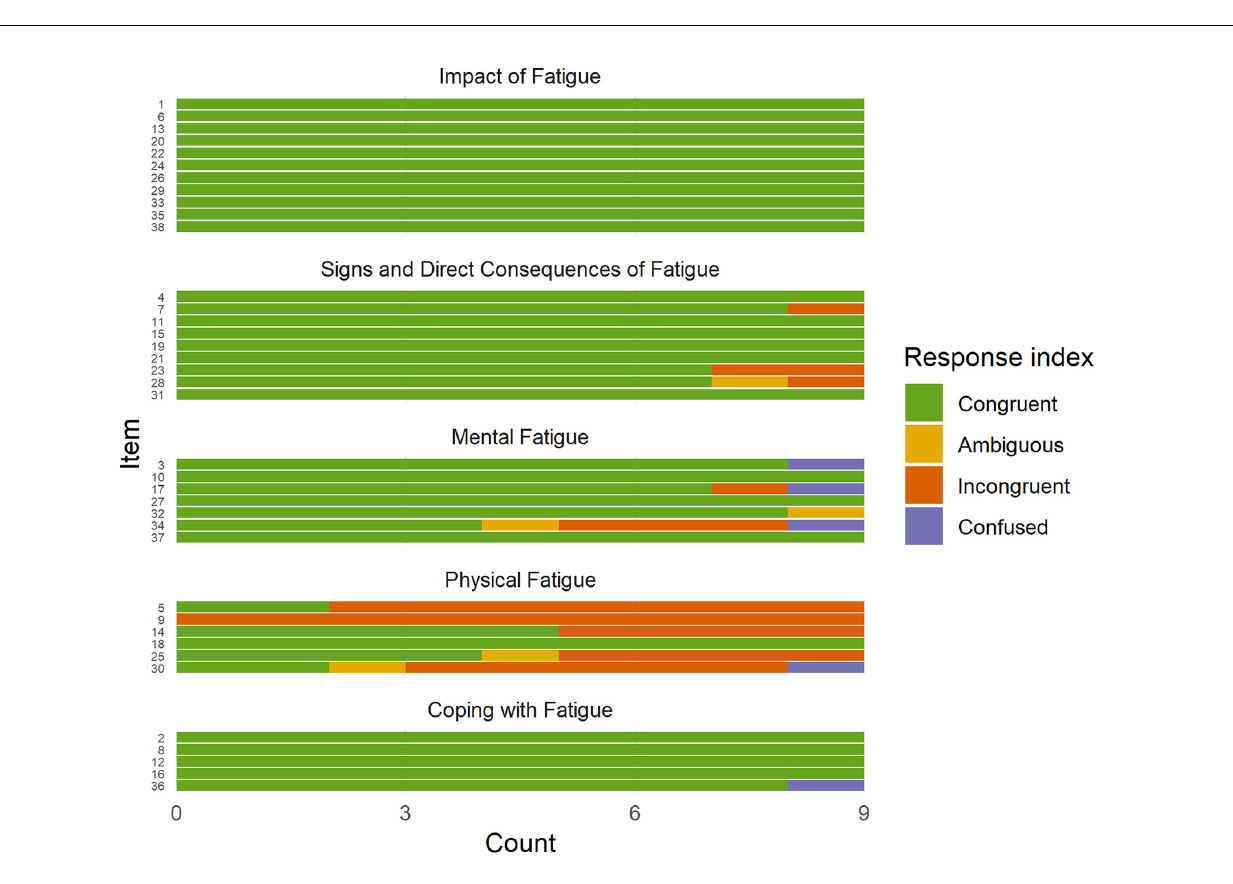
FIGURE 1 | Distribution of indexed response processes of nine individuals with stroke to items of the Dutch Multifactor Fatigue Scale (DMFS). Note. The interpretative process in responding to items of the DMFS was indexed using the following categories: (i) Congruent (i.e., observed response was related to